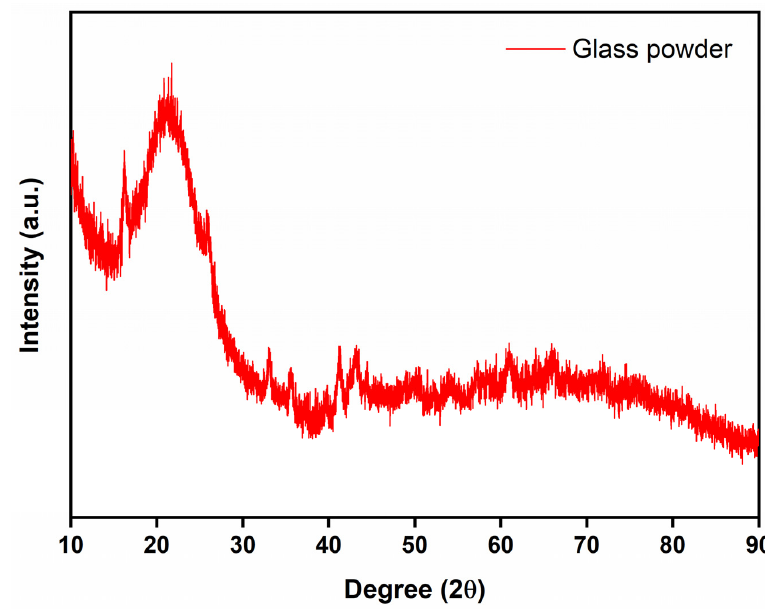
Figure 1. XRD pattern of the prepared glass powder.